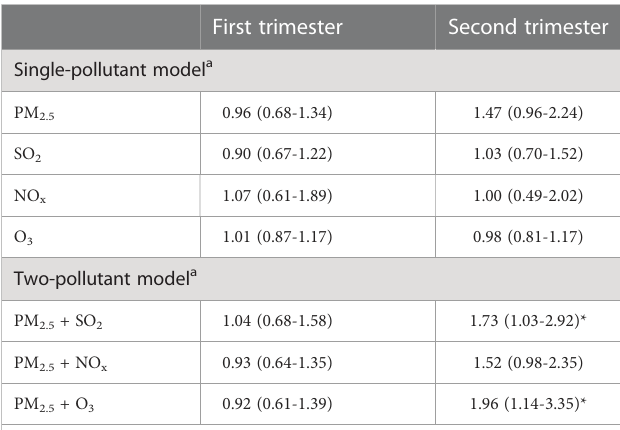
Data are odds ratio (95% CI). GDM, gestational diabetes mellitus. PM, particulate matter. SO 2 , sulfur dioxide. NO x , nitrogen oxides. O 3 , ozone. a Logistic regressions with adjustments for individual-speci fi c effects (age, nulliparous/parous, body mass index, season, and year) and for moving averages of humidity and temperature in the corresponding study period.